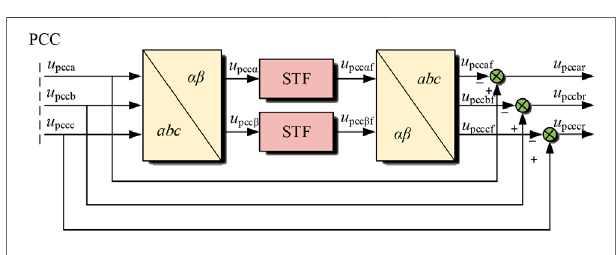
FIGURE 7 | Schematic diagram of resonance detection based on STF.